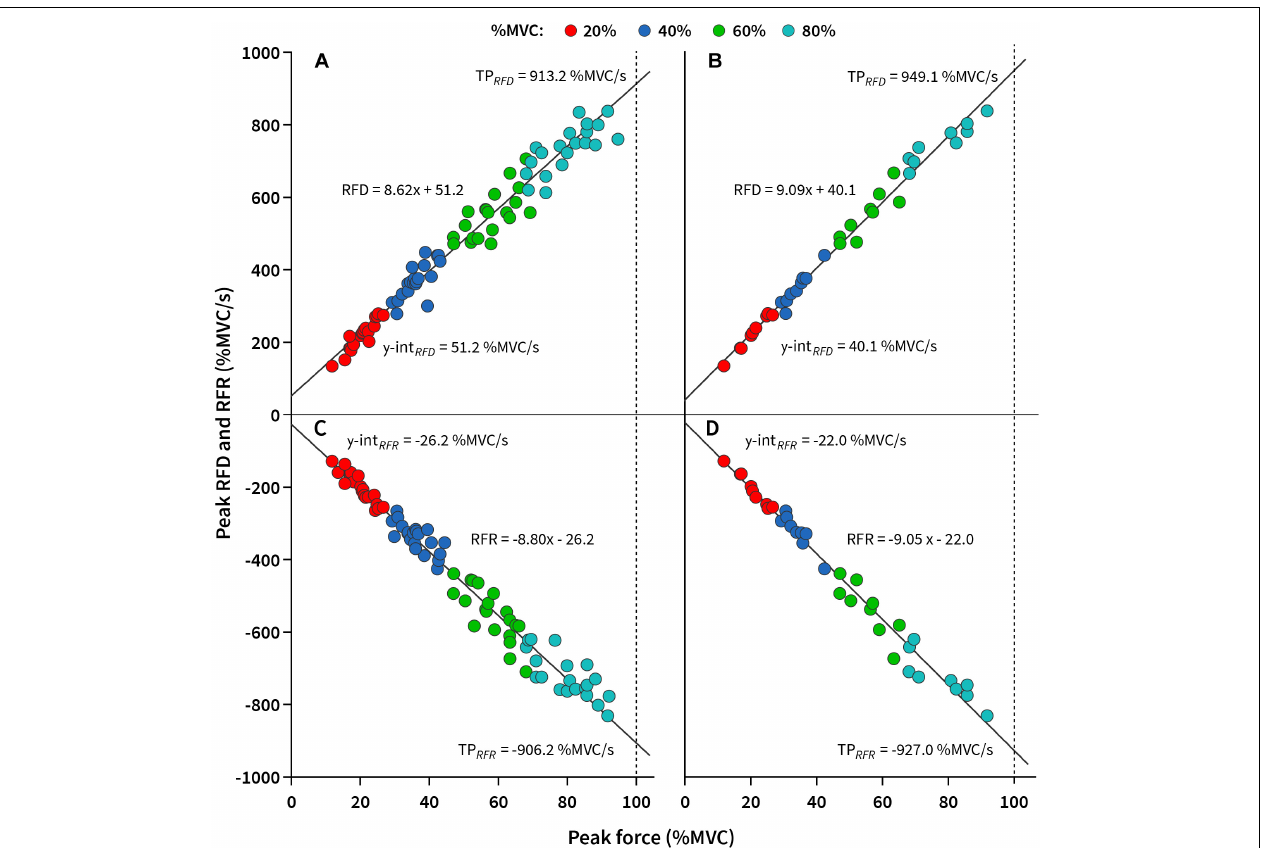
FIGURE 2 | The slope of rate of force development/relaxation scaling factor (k RFD − SF /k RFR − SF ) of a representative subject interpolated to a data scatter. (A) k RFD − SF calculated based on the standard protocol (100–120 pulses). (B) k RFD − SF calculated based on the reduced protocol (36 pulses). (C) k RFR − SF calculated based on the standard protocol (100–120 pulses). (D) k RFR − SF calculated based on the reduced protocol (36 pulses). y-int RFD , y-intercept of RFD-SF; y-int RFR , y-intercept of RFR-SF; TP RFD , theoretical peak rate of fore development; TP RFR , theoretical peak rate of force